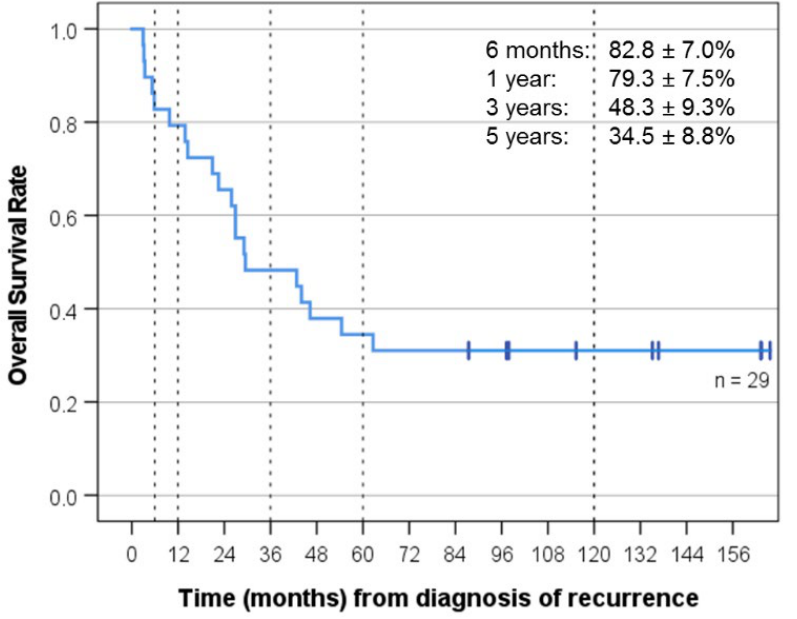
Figure 2. Overall survival (OS) for all 29 patients from time of diagnosis of recurrence that prompted MEMMAT-like therapy. Median OS was 29.5 months (KI 2-57).